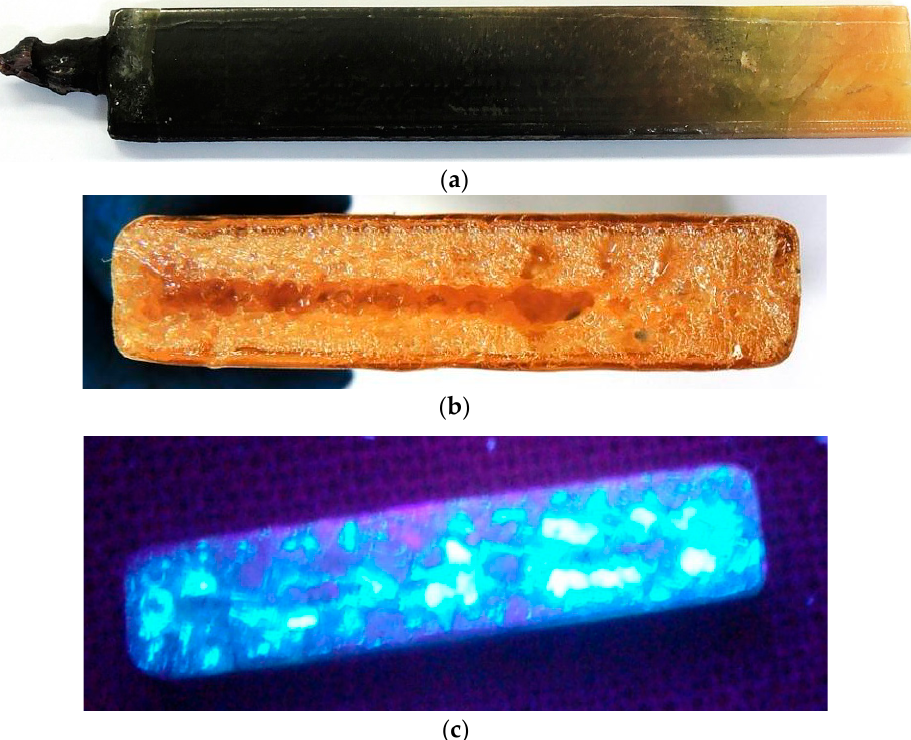
Figure 1. CeAlO 3 single crystalline samples before ( a ) and after ( b ) annealing at 1700 °C in the Ar and CO reducing atmosphere.